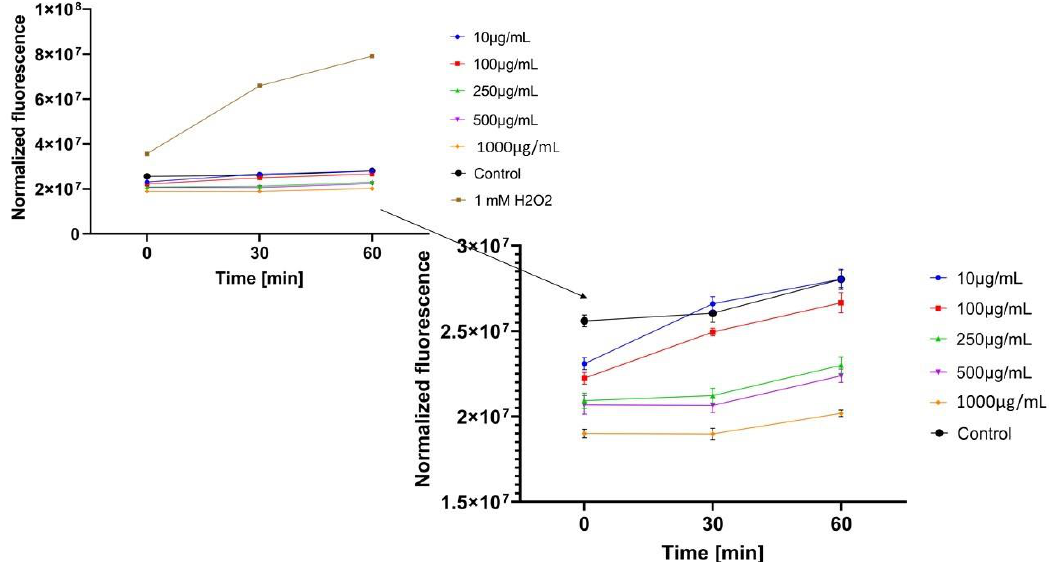
Figure 9. The effect of Epilobium angustifolium L. extract on the 2’,7’-dichlorofluorescein (DCF) fluorescence in fibroblast cells (BJ). The data are expressed as the mean ± SD of 3 independent experiments, each of which consisted of 3 replicates per treatment group.